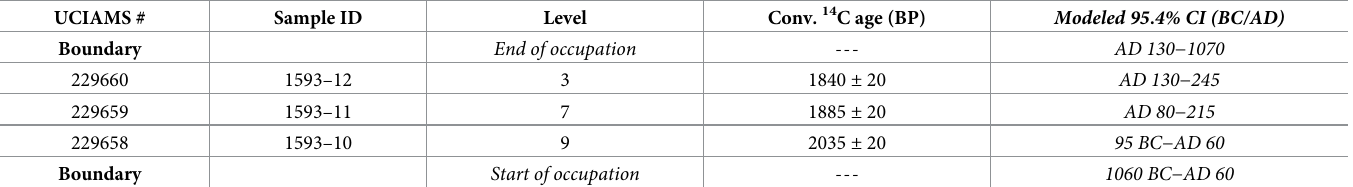
Table 5. Radiocarbon dates for unit SE3C, including modeled sequence, 95% probability ranges, and boundaries. UCIAMS